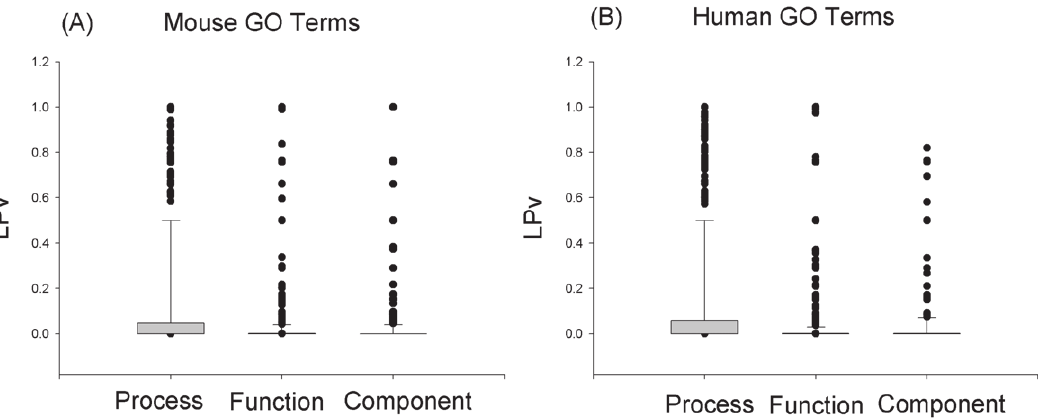
Figure 3. Box plot of LPv distributions for gene sets in the three main mouse and human GO categories. doi:10.1371/journal.pone.0018851.g003 PLoS ONE |